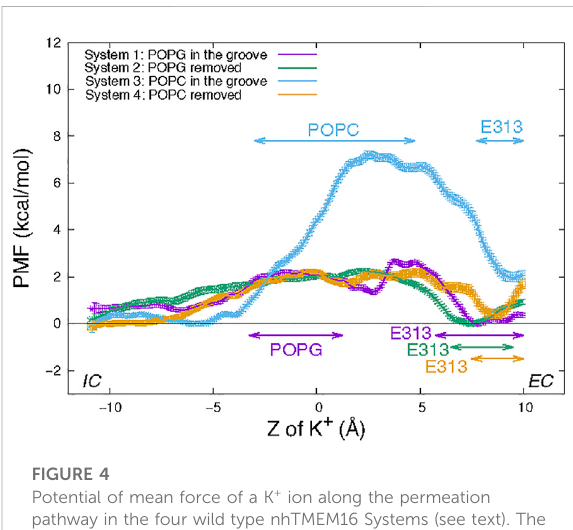
FIGURE 3 | FIGURE 3 groove POPG lipid. (G,H) Distance between the EC gate residues, E313 and R432. The dynamics are presented in the Supplementary Movies